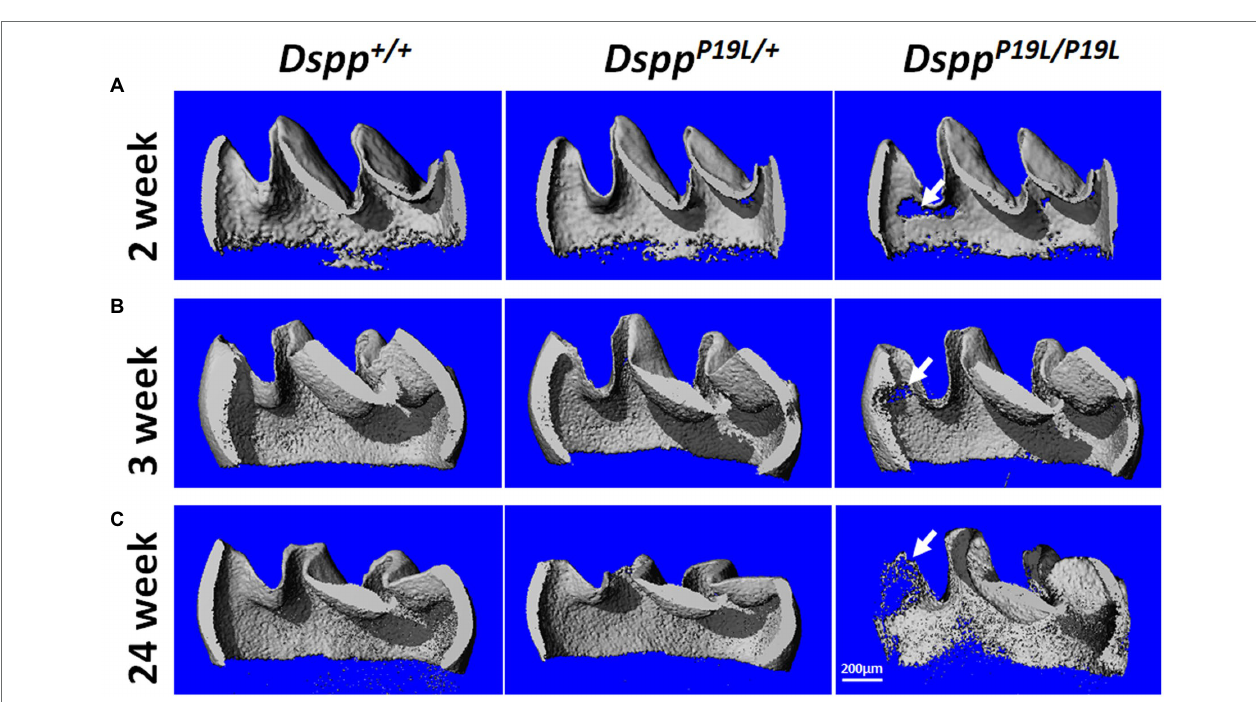
FIGURE 3 | Micro-Computed Tomography ( μ CT) analyses of the mandibular first molars. Shown are the representative 3D reconstructed μ CT images (sagittal sections) of enamel of the mandibular first molars of 2-week-old (A) , 3-week-old (B) , and 24-week-old (C) wild-type Dspp +/+ , heterozygous Dspp P19L/+ , and homozygous Dspp P19L/P19L mice. The enamel was poorly formed in Dspp P19L/+ and Dspp P19L/P19L mice, particularly in Dspp P19L/P19L mice (arrows), at the age of 2 weeks. There was also a severe loss of enamel in the Dspp P19L/P19L mice (arrows) with age, in comparison to age-matched Dspp +/+ and Dspp P19L/+ mice. Scale bar: 200 μ